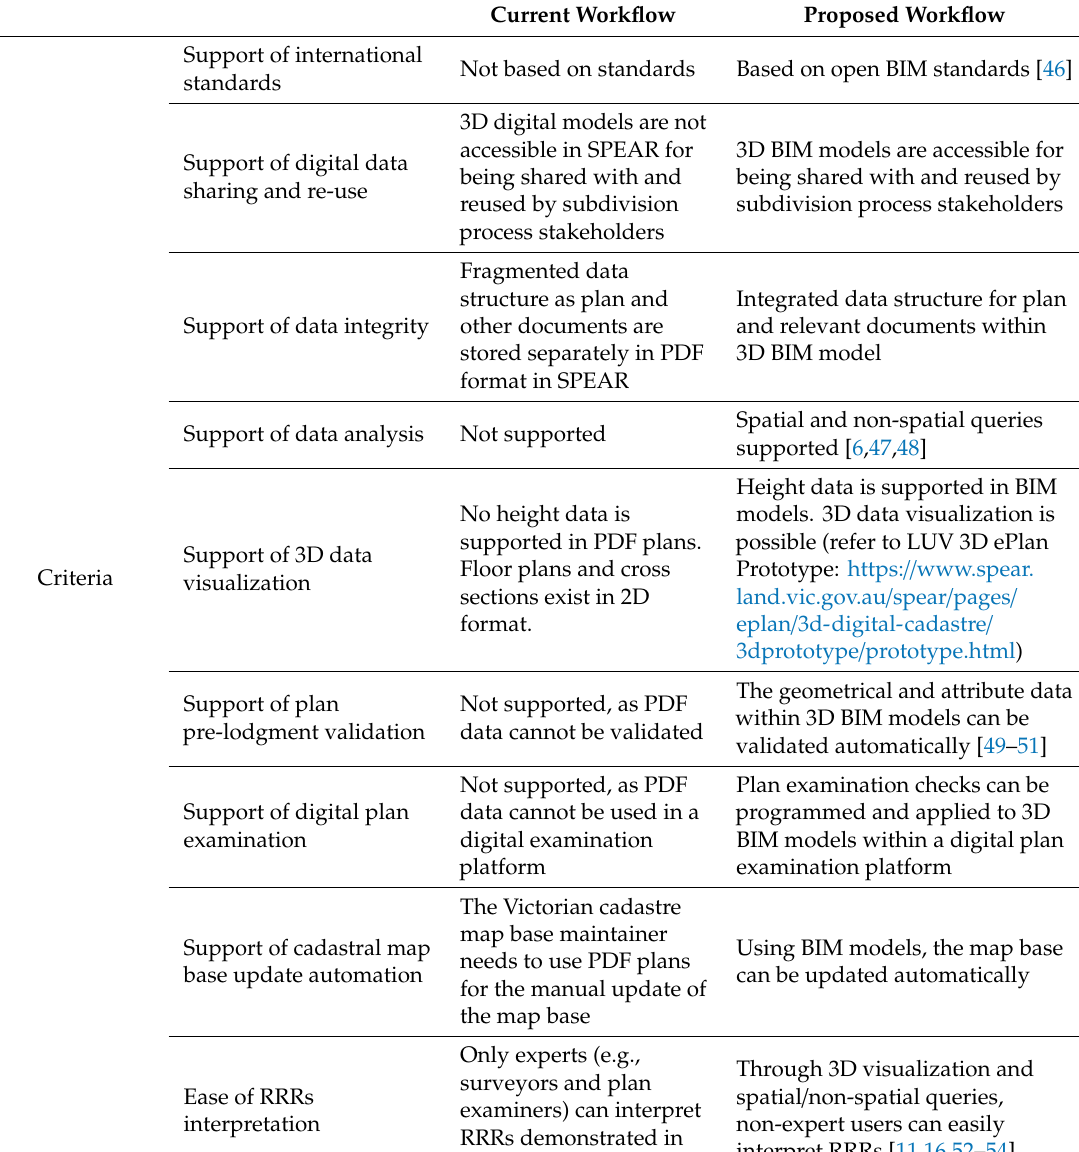
Table 6. Comparison of current and proposed building subdivision